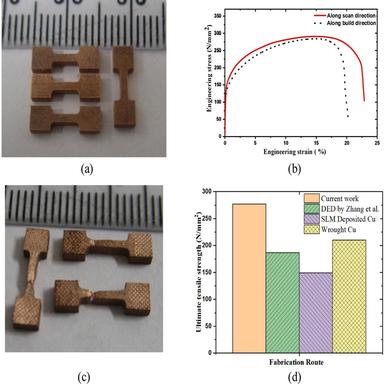
Micro-tensile of LDED build (a) Specimen before the test (b) Specimen after test (c) Representative engineering stress-strain curve (d) Comparison of UTS of built Cu.